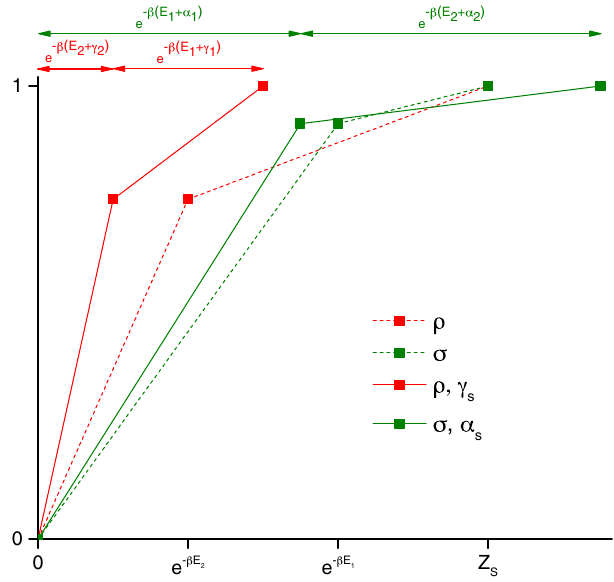
P n p s ih s j with s j s ¼ 1